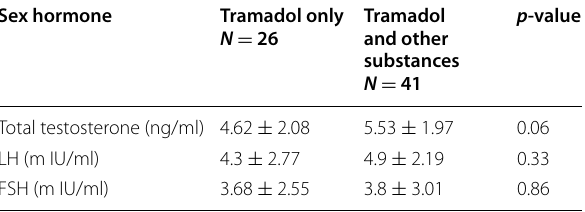
P ‑value of independent T ‑test < 0.05* is statistically significant. N Normal range for total testosterone (2.62–15.9 ng/ml), for LH (1.7–11.2 m IU/ml), for FSH (2.0–18.6m IU/ml)